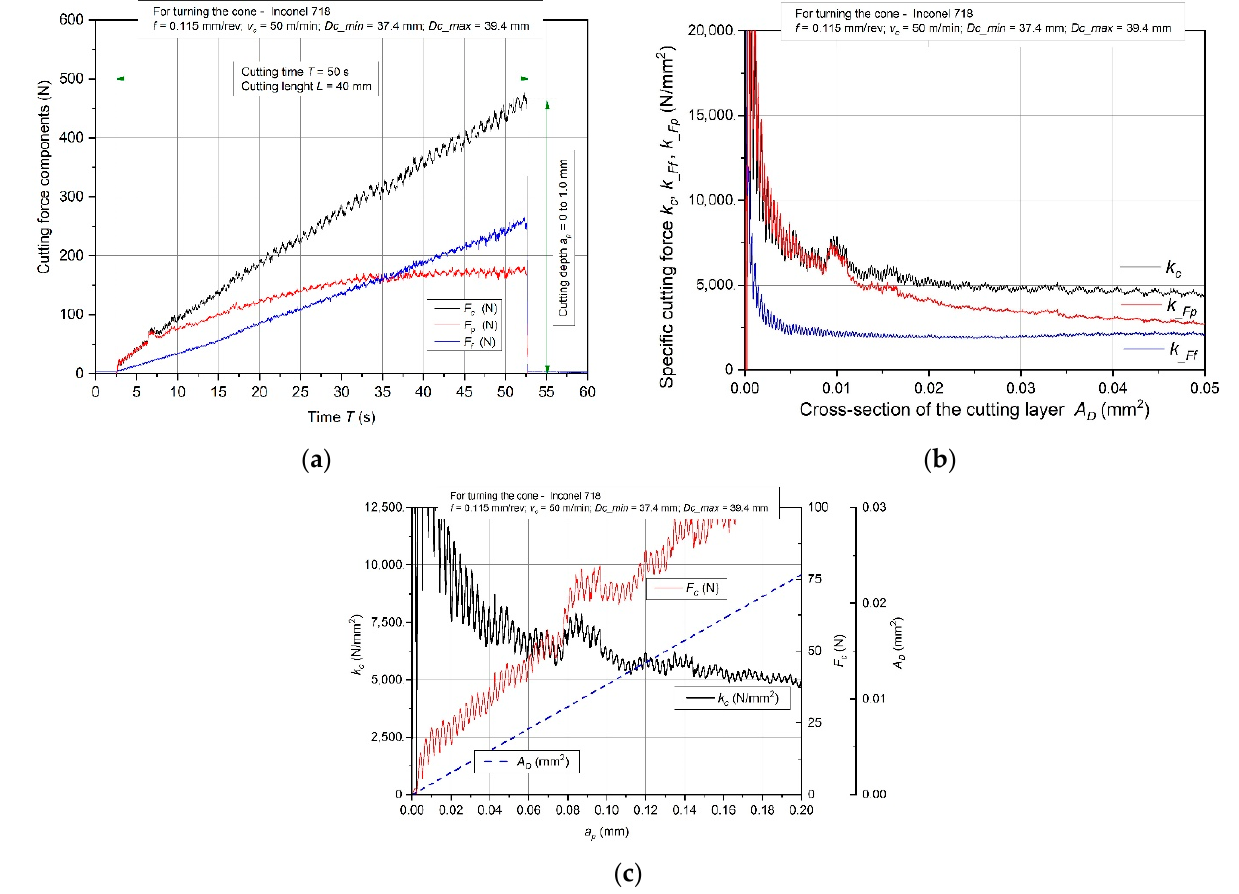
Figure 2. Characteristics of the components F c , F f , F p ( a ) with specific cutting forces ( b ) and specific cutting force k c during the initial phase of cutting edge work ( c ) for turning the cone made of Inconel 718 alloy.